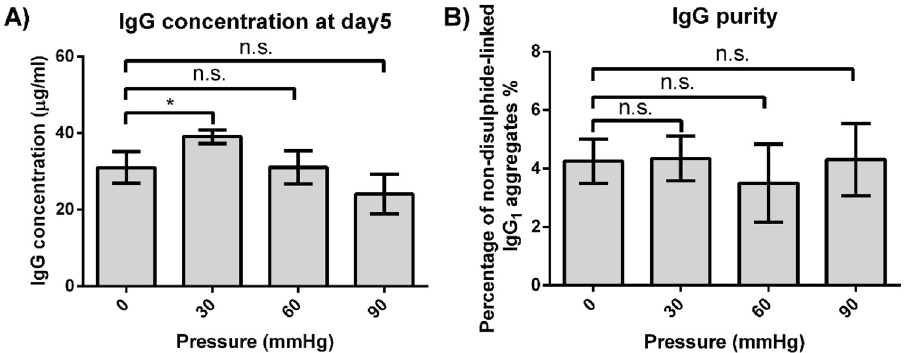
Figure 4. Antibody concentration and non-disulphide-linked IgG 1 aggregates under different pressure conditions. ( A ) Overall IgG 1 concentration measured on Day 5. ( B ) The proportion of IgG 1 aggregates under reducing condition on Day 5. ( n = 3) *Denotes statistical significance ( p < 0.05) while n.s. denotes no statistically significant difference ( p > 0.05).